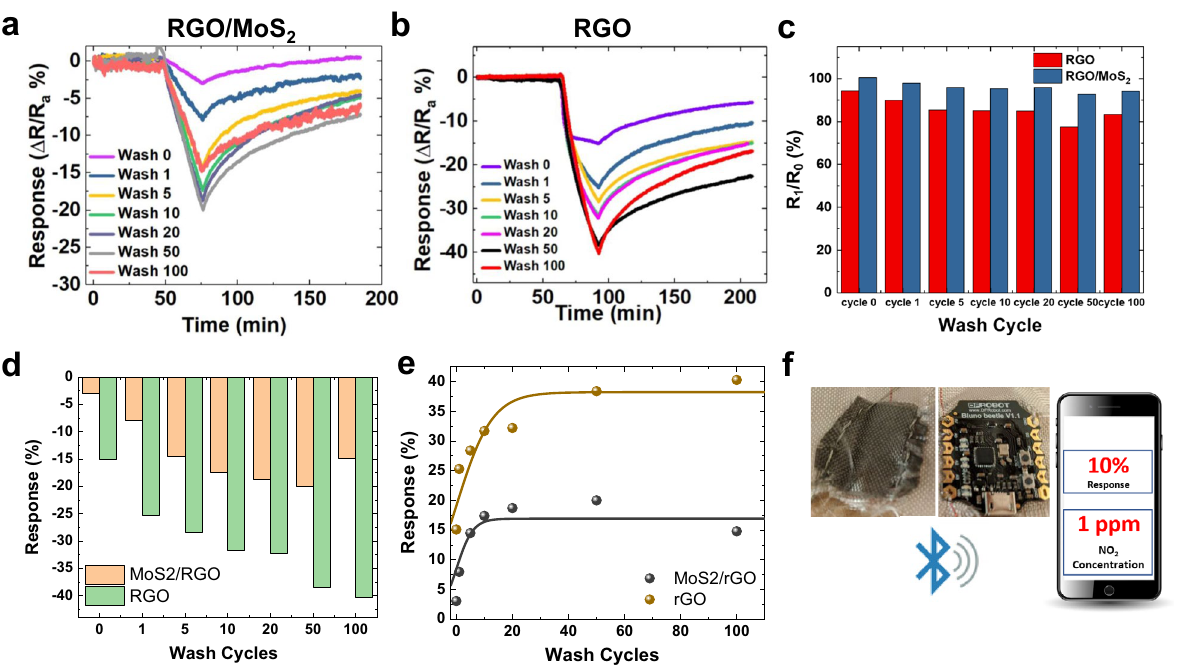
Figure 4. Textile gas sensing in humid air with washing. ( a ) Gas sensing response of the RGO/MoS 2 -coated and ( b ) RGO-coated fabric to 100 ppb NO 2 in humid air. The change in resistance expressed as a percentage for the fabric before exposure to NO 2 , during exposure to NO 2 , and after exposure to NO 2 —with partial recovery. ( c ) Recovery of the RGO and RGO/MoS 2 -coated fabric after exposure to a fixed concentration of 100 ppb NO 2 after 2 h. ( d , e ) show the sensor response dependency of the RGO/MoS 2 and RGO coated fabric on the number of washing cycles. ( f ) Device integration showing the sensor integrated to fabric, the micro-controller and the mobile